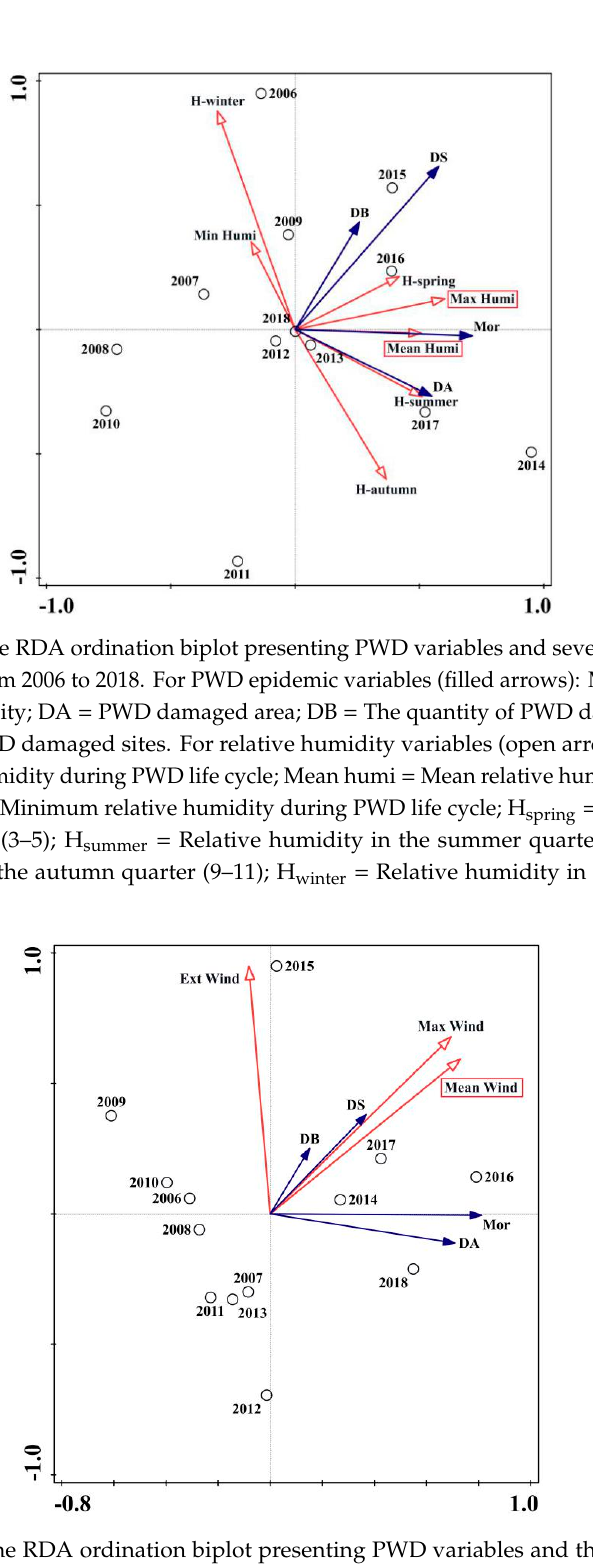
Figure 6. Results of the RDA ordination biplot presenting PWD variables and three selective wind speed variables from 2006 to 2018. For PWD epidemic variables (filled arrows): Mor = The quantity of Masson pine mortality; DA = PWD damaged area; DB = The quantity of PWD damaged blocks; DS = The quantity of PWD damaged sites. For wind speed variables (open arrows): Ext wind = Extreme wind speed from May to September; Max wind = Maximum wind speed from May to September; Mean wind = Mean wind speed from May to